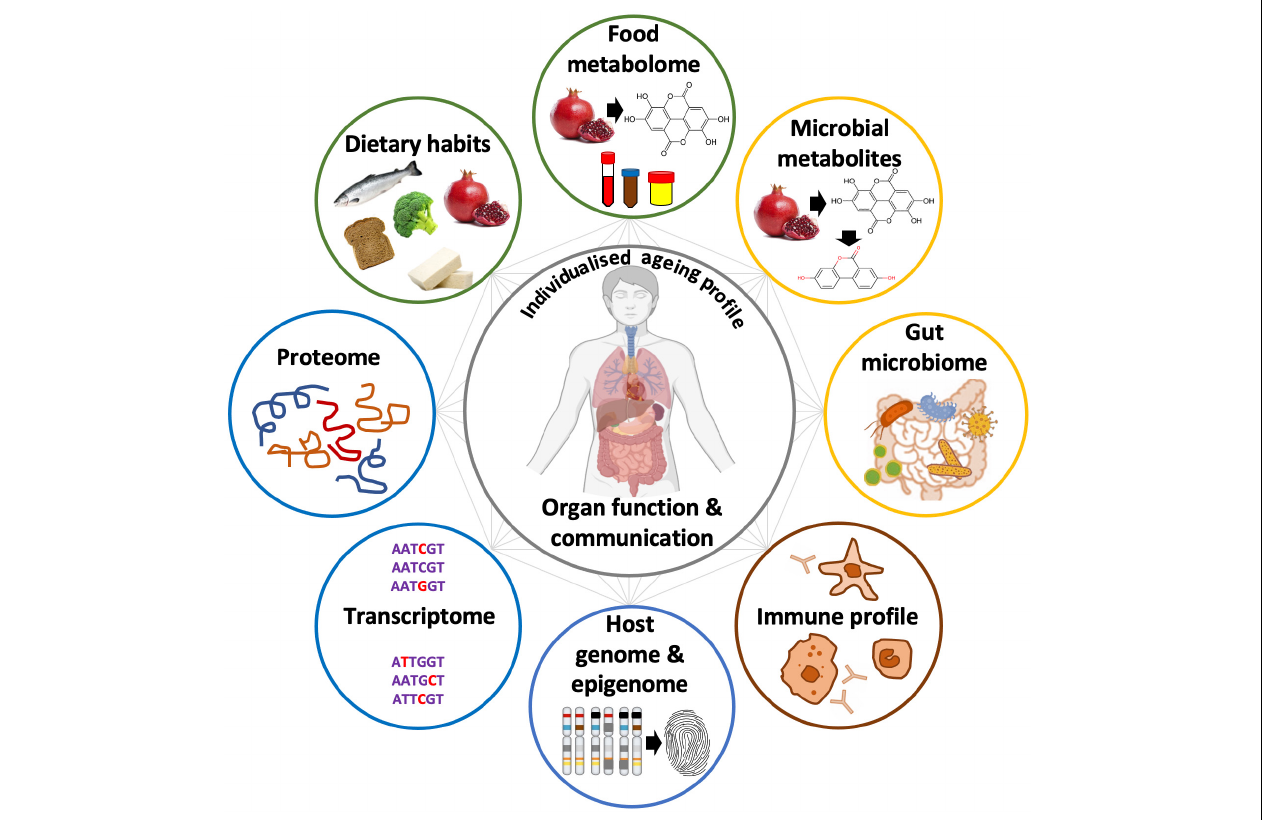
FIGURE 2 | Life-long accumulation of damage to body functions and organ systems leads to a discrepancy between chronological and biological ageing. Further, these individual nodes and inter-organ crosstalk may contribute to variability of an individual’s ageing